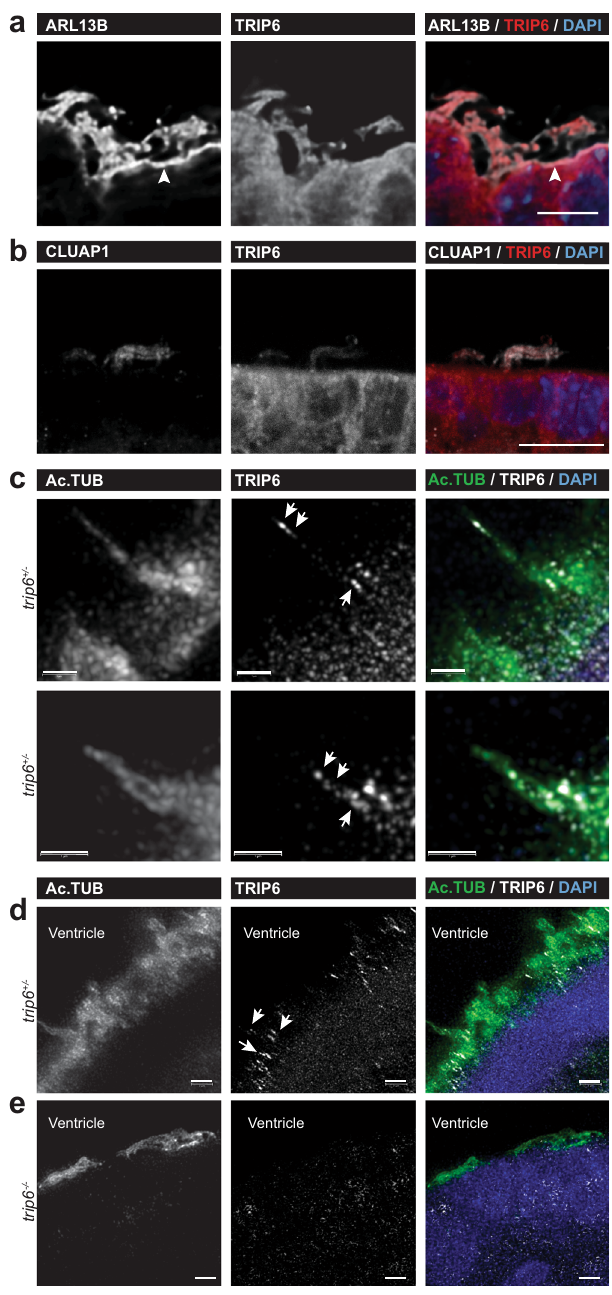
Fig. 7 Localization of TRIP6 in motile cilia of brain ependyma, via super resolution microscopy. Co-localization of TRIP6 with the cilia markers ARL13B ( a ) and CLUAP1 ( b ) in cilia of control mice ependyma, via double-labeling immuno fl uorescence microscopy (Arrowhead indicates localization of ARL13B also at the ventricular membrane, see